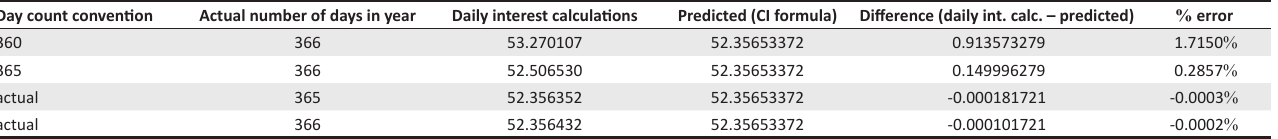
TABLE 2: Comparison of daily interest calculations versus predicted amounts. Day count